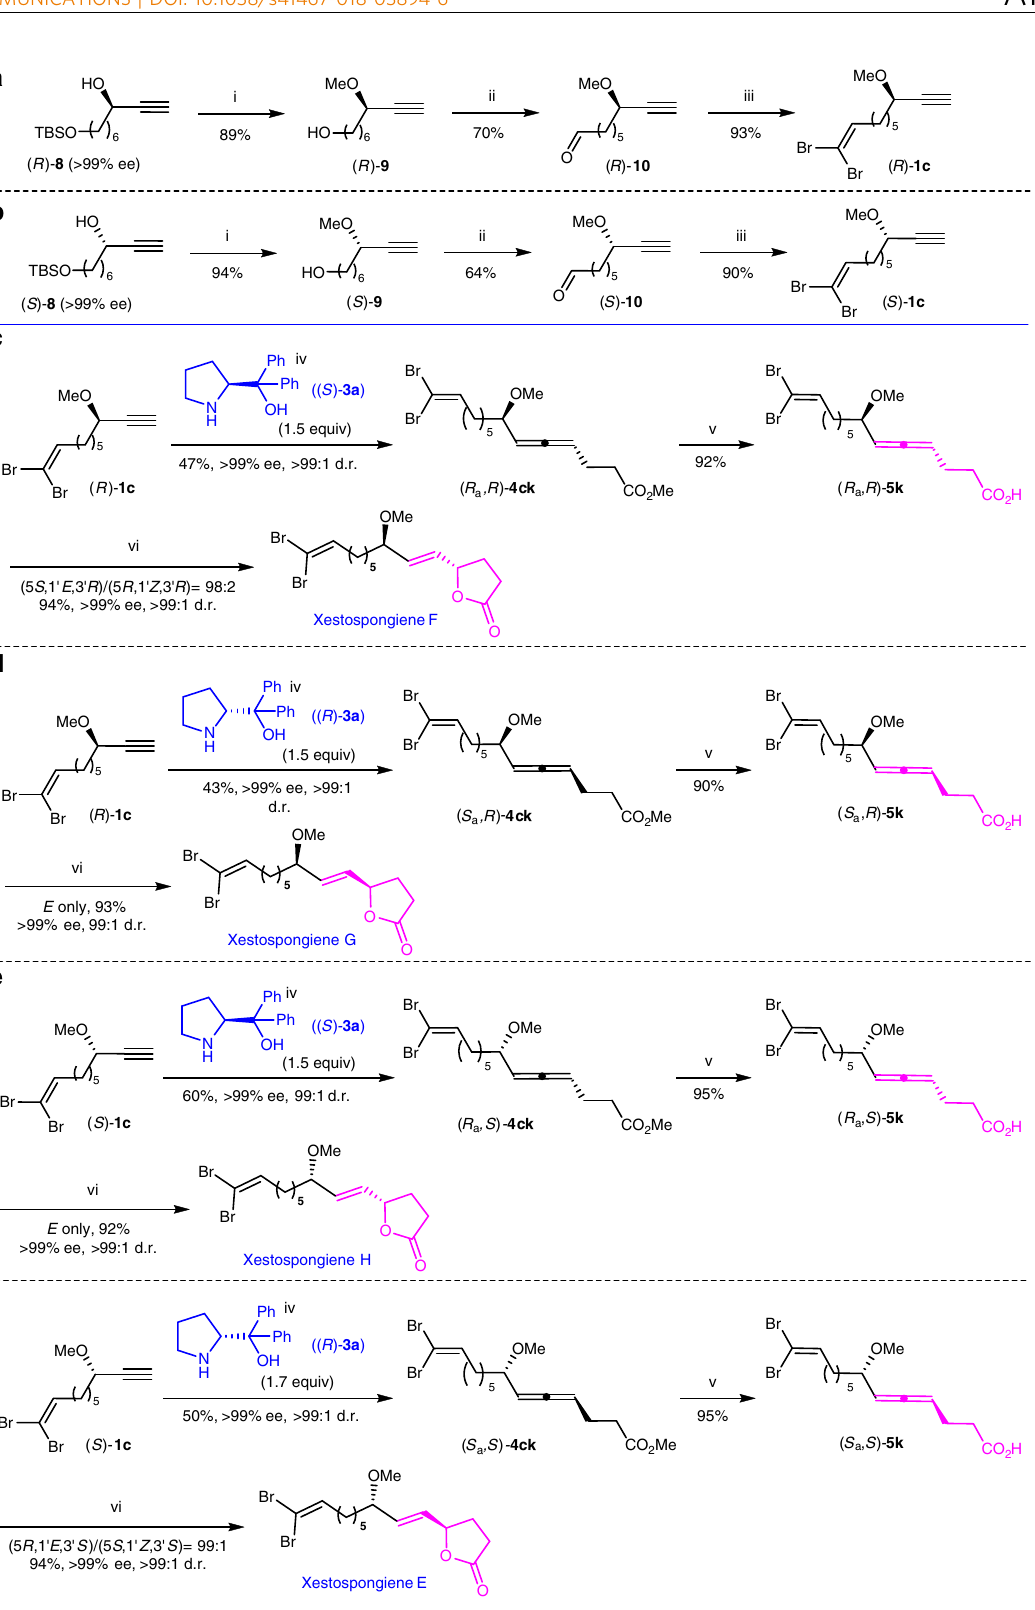
Fig. 6 First total synthesis of xestospongienes E – H. a Synthesis of ( R )- 1c ; b Synthesis of ( S )- 1c ; c Total synthesis of xestospongiene F; d Total synthesis of xestospongiene G; e Total synthesis of xestospongiene H; f Total synthesis of xestospongiene E. Reagents and conditions: i. NaH (1.0 equiv.), THF, 0 °C then rt; then MeI (1.2 equiv.), 0 °C ~rt; then HCl (aq., 3.0 M), MeOH, rt; ii. Fe(NO 3 ) 3 ∙ 9H 2 O (10 mol%), TEMPO (10 mol%), NaCl (10 mol%), O 2